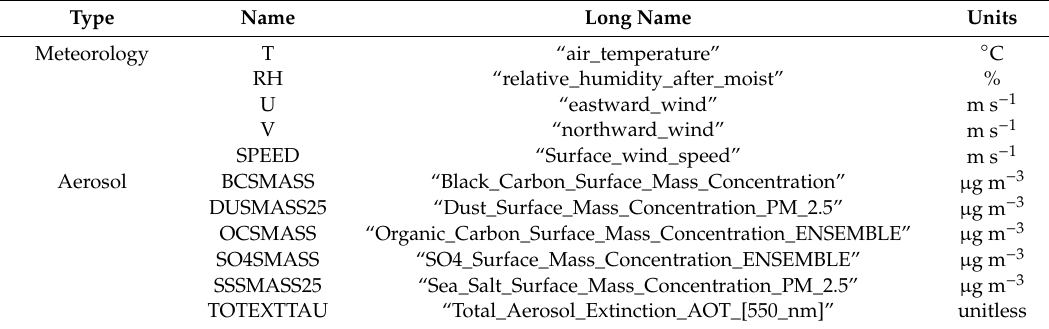
Table 1. Meteorological and aerosol SDS from